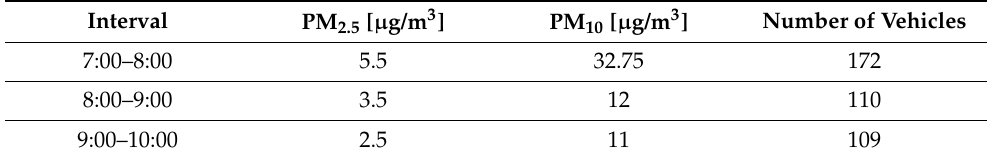
Table 5. Hourly particulate emissions in measurement